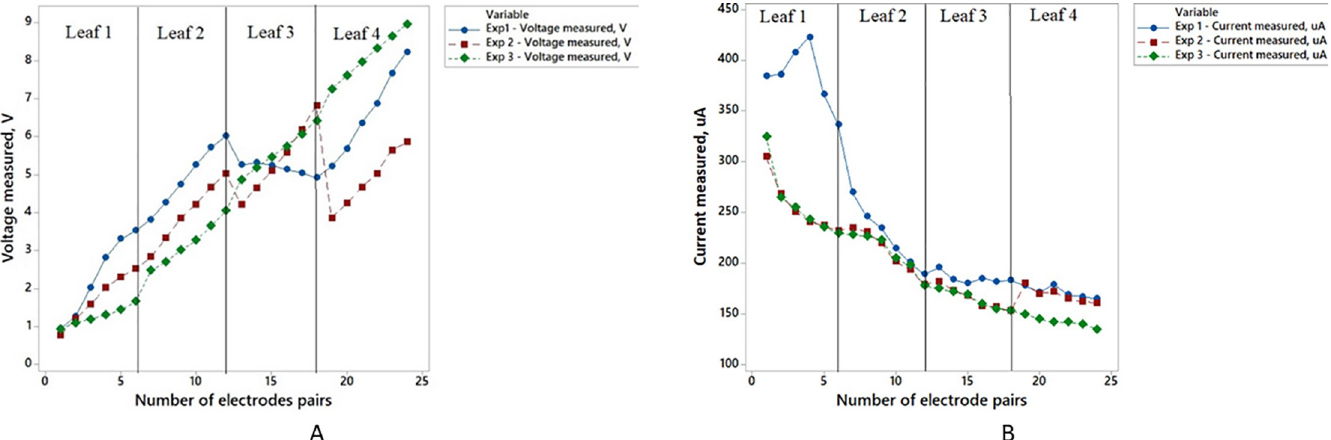
Fig 17. Comparison of electrical output for Exp1-3. Comparison in terms of output voltage (A) and output current (B).